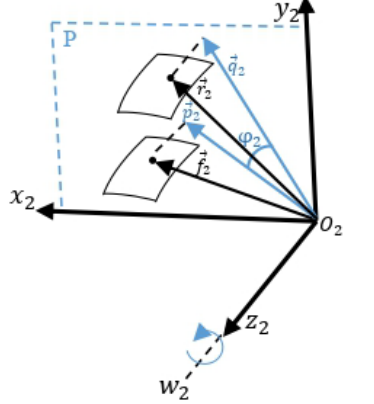
on plane around a fixed axis 𝜙𝜙 2 𝑃𝑃